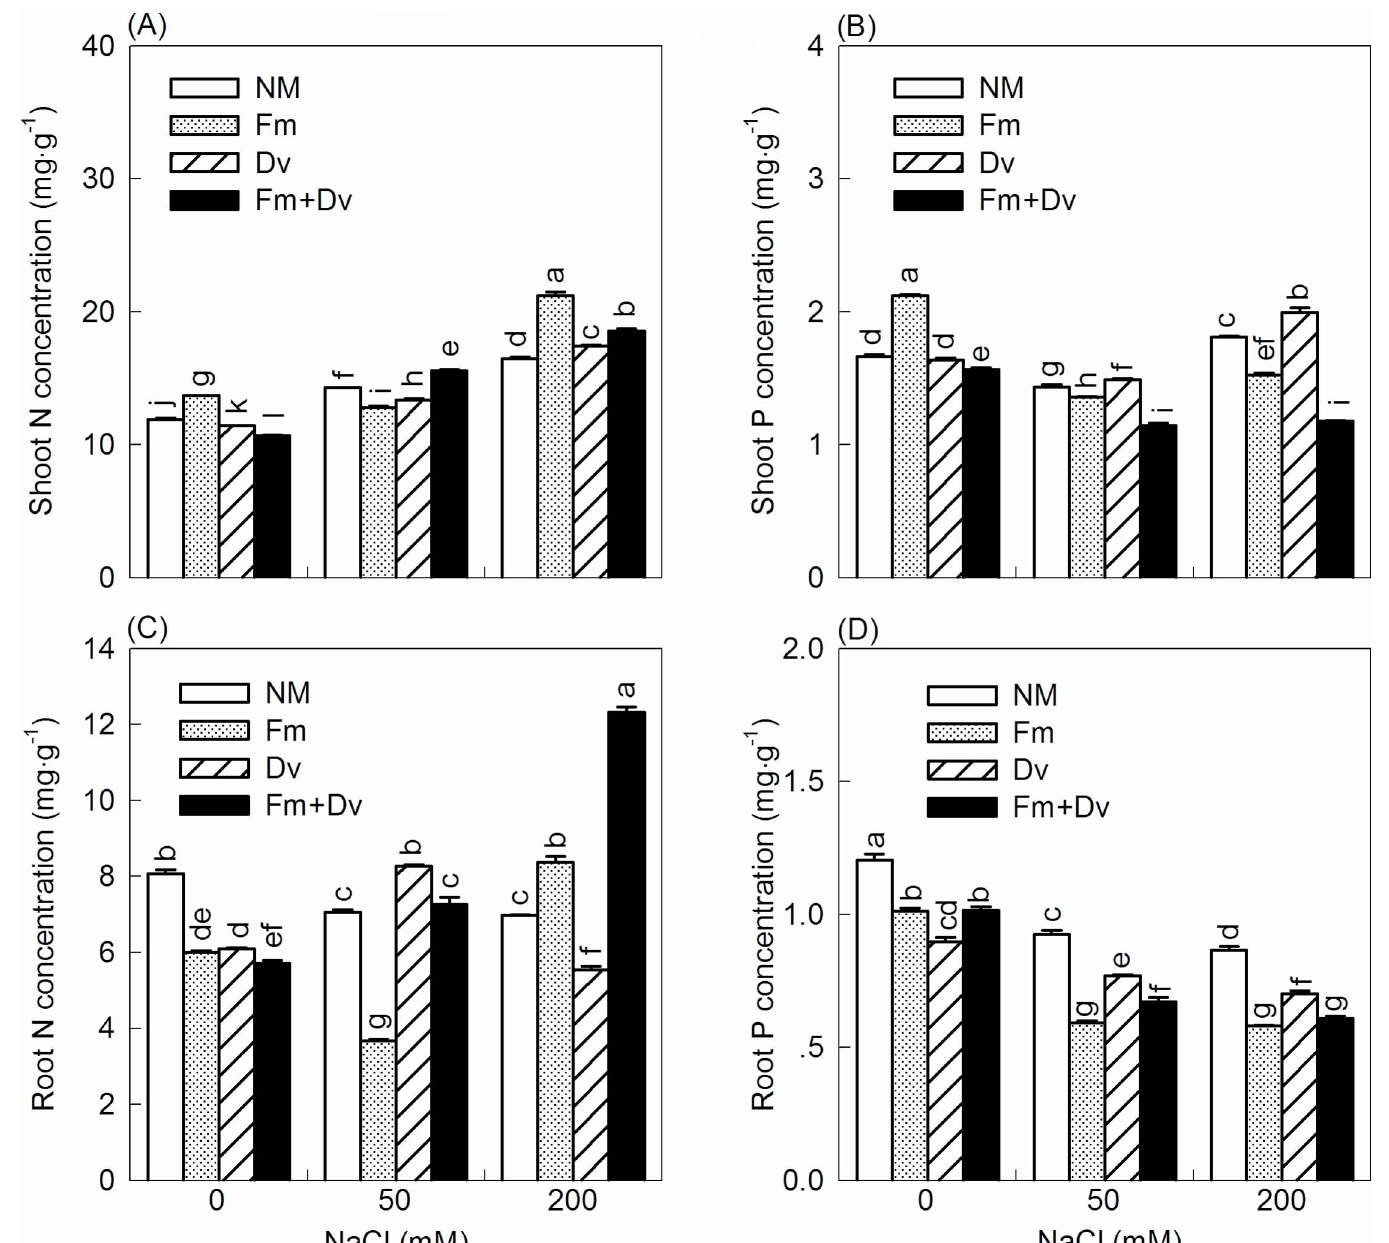
Fig 4. Effects of arbuscular mycorrhizal fungi on shoot N concentration (A), shoot P concentration (B), root N concentration (C) and root P concentration (D) of C . morifolium plants under 0, 50 and 200 mM NaCl. Symbols are the same as in Fig